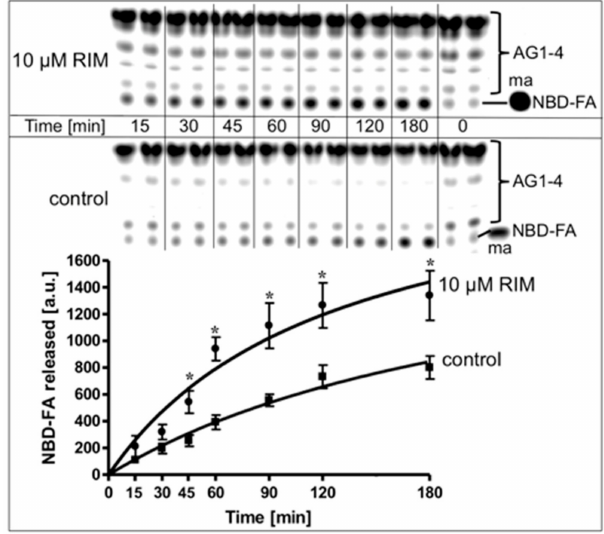
Figure 8. Stimulation of lipolysis in a cell-free system by Rimonabant. LD prepared from untreated rat adipocytes, which had been metabolically labelled with NBD-FA, were reconstituted with partially purified rat adipocyte HSL (see Materials and Methods) and then incubated (30 ◦ C) for increasing periods in the absence (control) or presence of Rimonabant. The organic phase of the chloroform / methanol / HCl-extract of the total incubation mixture was analyzed by thin layer chromatography (TLC). The amount of NBD-FA lipolytically released from the NBD-FA-labelled acylglycerols (AG) 1–4 and run in parallel to a synthetic NBD-FA marker (ma) was quantitatively evaluated by fluorescence imaging. A fluorogram of a typical experiment with TLC runs in duplicate repeated two times is shown with quantitative evaluation (mean ± SD) of three independent incubations withTLCanalysisinduplicate. * p ≤